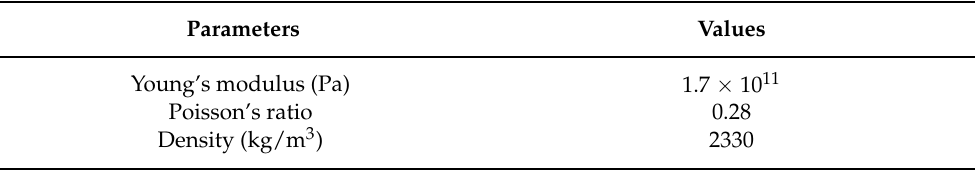
Table 2. Material parameters for FE